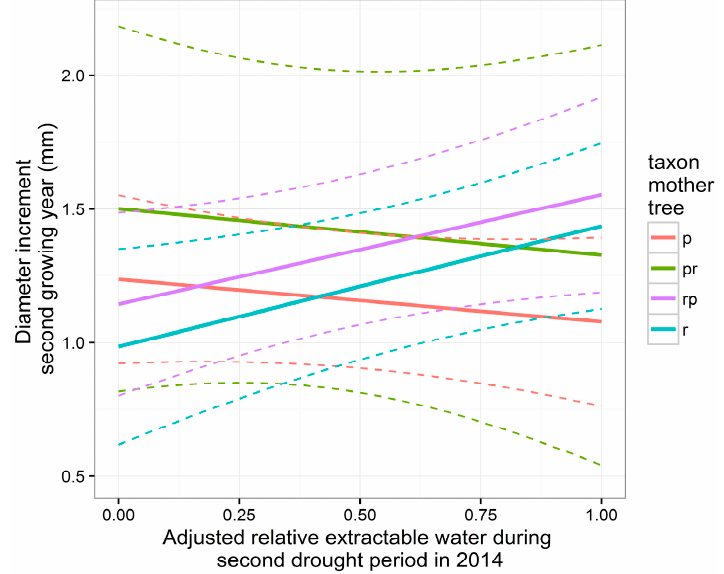
Figure 5. Modelled diameter growth in the second growing season (2015) depending on the adjusted relative extractable water of the pots during the second drought period in the first growing season and on the taxon of the mother tree. p: Q. petraea ; pr: long-stalked intermediate; rp: short-stalked intermediate; r: Q. robur (95% confidence intervals are shown with dashed lines).